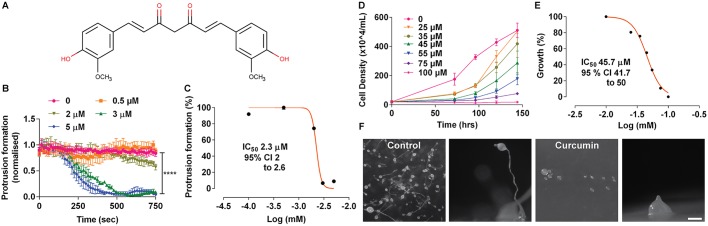
Acute cell behaviour, growth and developmental effects of curcumin on D.
discoideum. (A) Curcumin, a diferuloylmethane, was used to assess multiple roles using D. discoideum as a model. (B) Time-dependent changes in D. discoideum cell behaviour (membrane protrusion) were recorded over a 15-min period (±s.e.m.) at increasing concentrations of curcumin. Data are presented normalised to control conditions, showing a significant difference between control condition (vehicle) and 3 µM (****P<0.0001) using one-way ANOVA. (C) The concentration-dependent response is illustrated as the normalised reduction of cell behaviour (protrusion formation) against the Log (concentration) of curcumin, enabling calculation of an IC50 with a 95% CI. (D) D. discoideum cells were grown with increasing concentration of curcumin, causing a complete block at 100 µM, with (E) normalised concentration-dependent response shown plotted against Log curcumin (mM) concentration, providing an IC50 with 95% CI. (F) Cells were developed on agar over 22 h in control conditions (vehicle) and in the presence of 100 µM curcumin. Scale bar: 0.25 mm for both side view images. All experiments were carried out in triplicate.